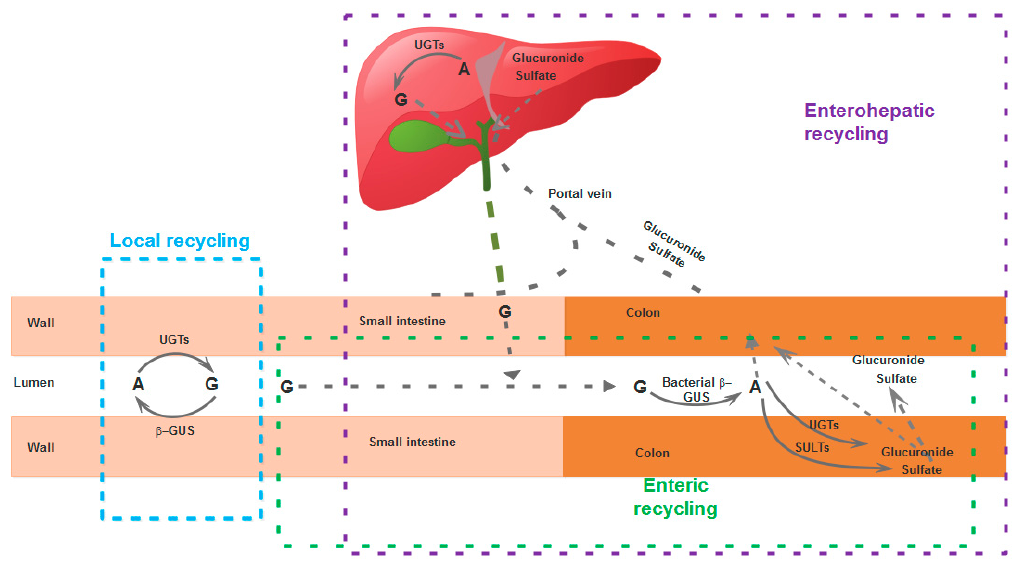
Figure 3. Schematic representation of different recycling scheme applicable to flavonoids. A: aglycones; G: glucuronide; β -GUS: β -glucuronidase; UGT: UDP-glucuronosyltransferases; ST: sulfotransferases.